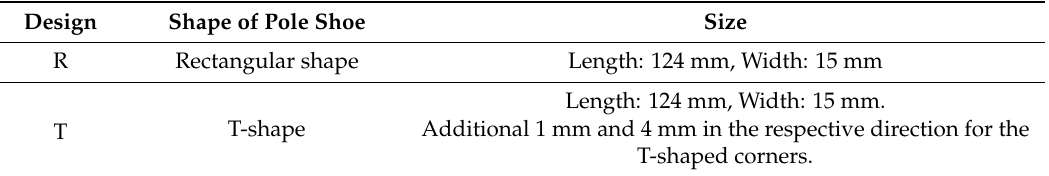
Table 3. Different designs of the pole shoes in the linear generator (LG).